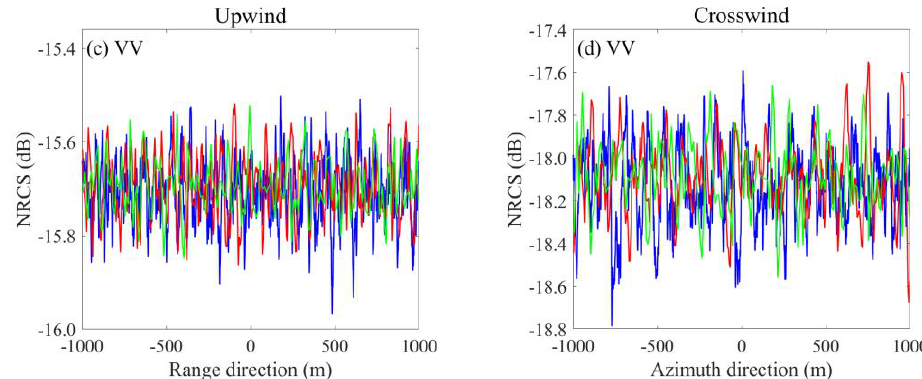
Figure 26. Comparisons of profiles of the sea surface height and profiles of scattering intensity under VV polarization based on different facet sizes in the upwind ( left ) and crosswind ( right ) directions at the incidence angle of 40° and wind speed of 10 m/s. The surface size is 2 km × 2 km. Blue solid curves, 1 m × 1 m; red solid curves, 5 m × 5 m; green solid curves, 10 m × 10 m. ( a ) Profiles of sea surface heights in the upwind direction; ( b ) profiles of sea surface heights in the crosswind direction; ( c ) profiles of NRCSs in the upwind direction; ( d ) profiles of NRCSs in the crosswind direction.